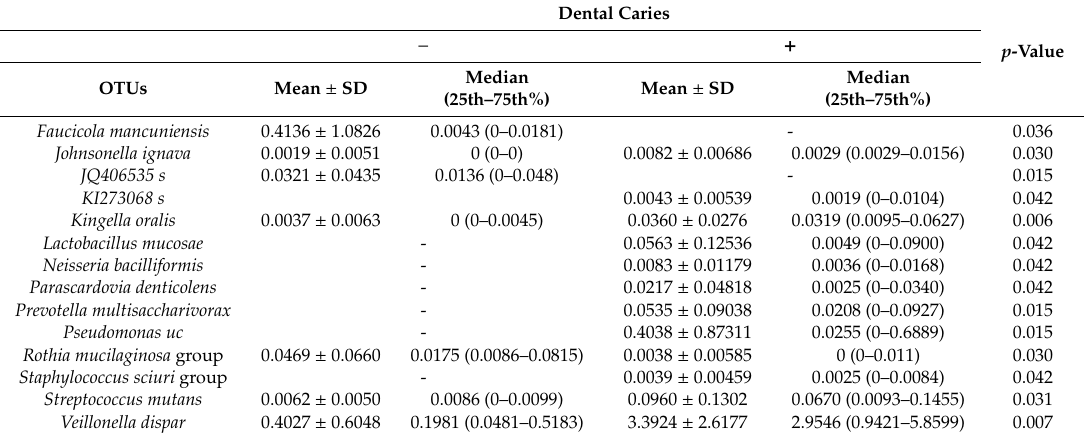
Table 2. The significantly di ff erent bacteria between subjects with or without dental caries at the species